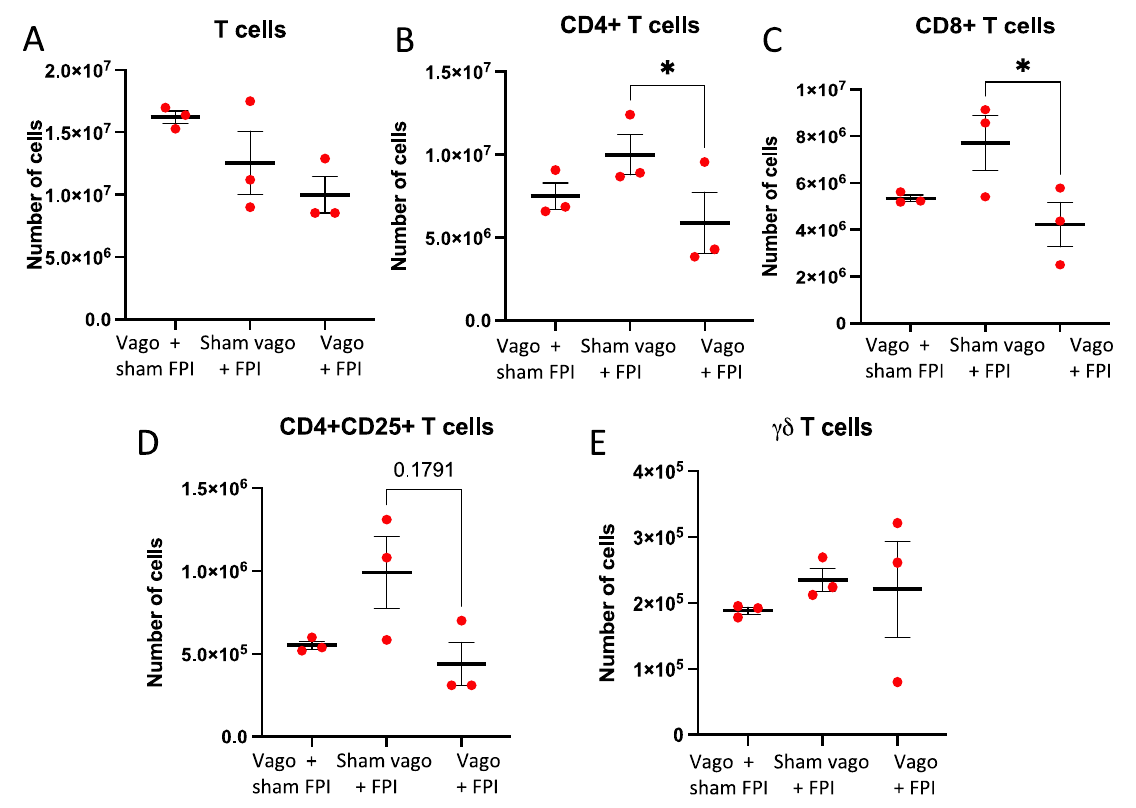
Figure 3. Vagotomy prevents FPI-induced expansion of specific T cell subsets. In ( A ), comparison of the number of CD3+ T cells following vagotomy + sham FPI (Vago + sham FPI), sham vagotomy + FPI (Sham vago + FPI), or vagotomy + FPI (Vago + FPI) showed no significant differences. In ( B ), examination of the number of CD4+ T cells (as stratified by expression of CD3+, CD19 − , CD4+, CD8 − ) showed a significant decrease in CD4+ T cells in the Vago + FPI compared to the Sham vago + FPI group. In ( C ), a significant decrease in CD8+ T cells (as determined by cell surface expression of CD3+, CD19 − , CD4 − , CD8+) in Vago + FPI compared to Sham vago + FPI was observed. There was also a trend towards increased CD8+ T cells in Sham vago + TBI compared to Vago + sham FPI. In ( D ), examination of CD4+CD25+ T cells characterizing CD4+ T regulatory cells (Tregs), as determined by cell surface expression of CD3+, CD19 − , CD4+, CD8 − , indicates that Sham vago + FPI results in a trend towards increased anti-inflammatory Tregs relative to Vago + sham FPI and Vago + FPI. In ( E ), there were no significant differences observed for the number of CD3+ γδ + T cells ( γδ T cells), as determined by cell surface expression of CD3+CD19-TCR γδ +; * = p < 0.05.